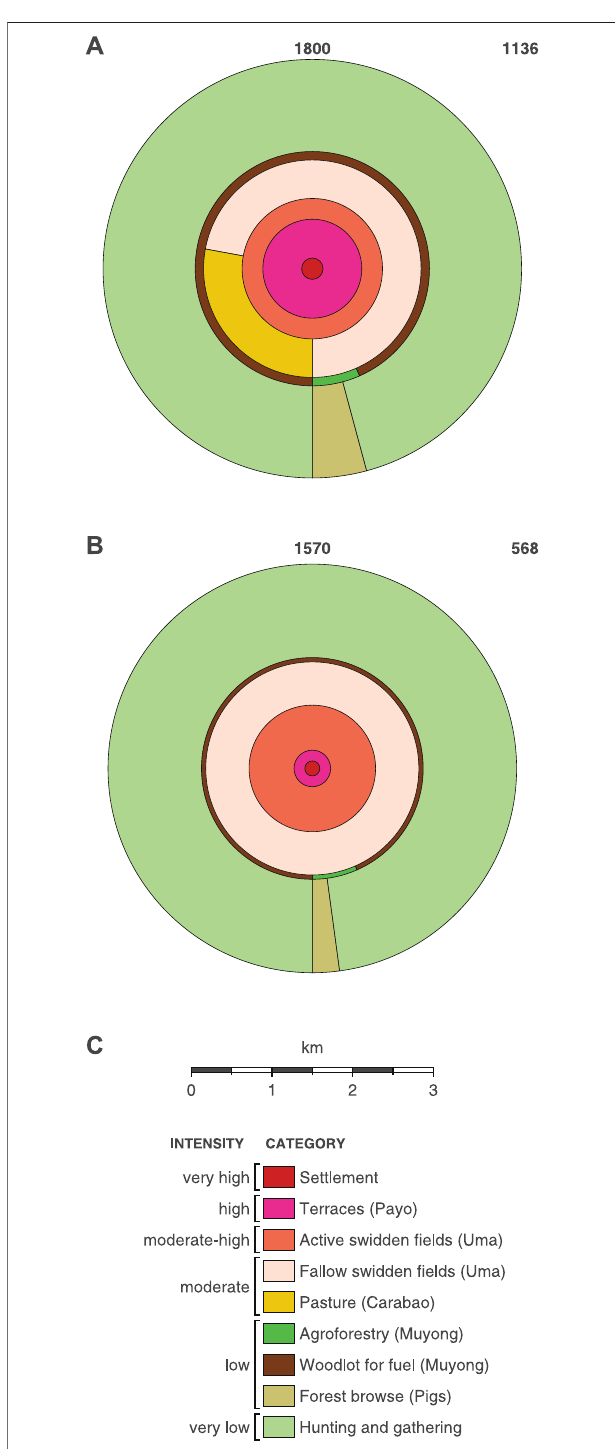
FIGURE 3 | Template circle diagrams for OKV in 1800 ( Panel A) and in 1570 ( Panel B) . The fi gure also includes a legend ( Panel C) with a scale. The legend lists all types of land use and their intensity relative to one another. In each panel, the number in the upper right corner represents the population whose land use is being